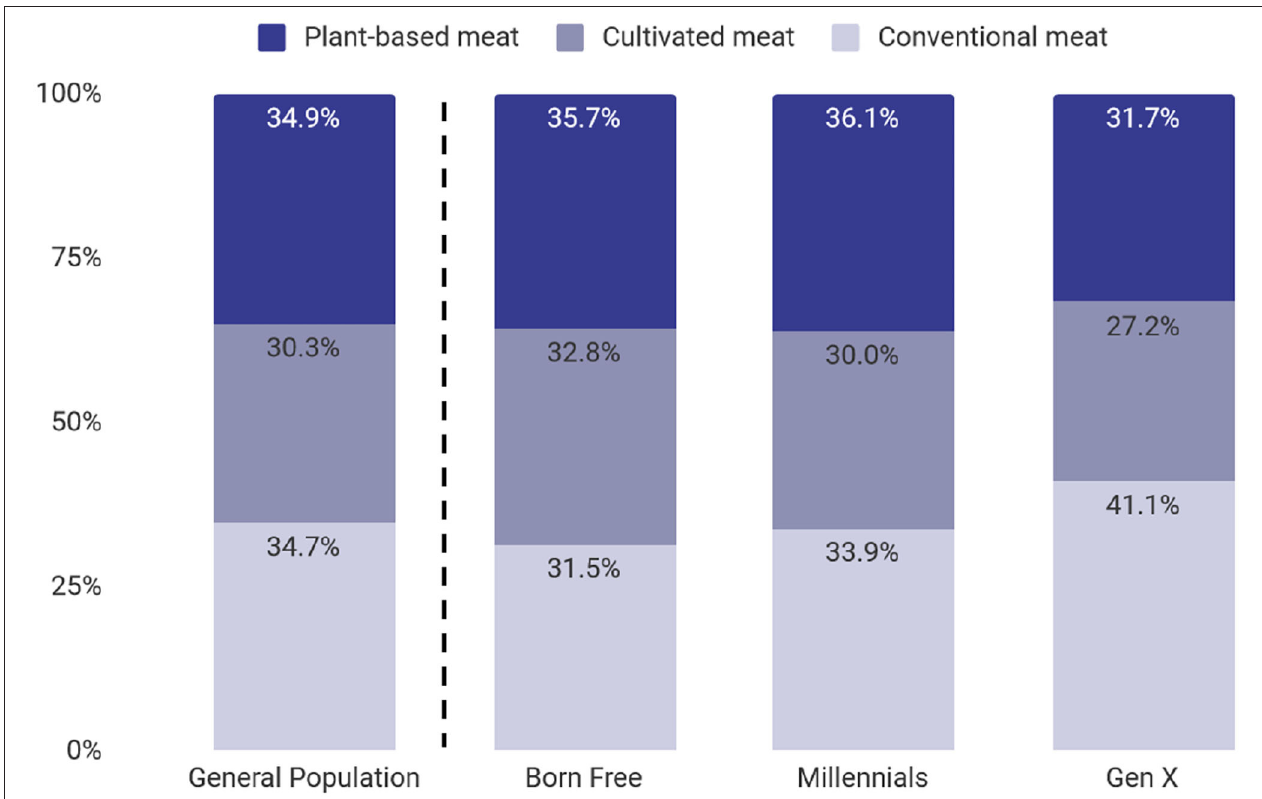
FIGURE 10 | Estimated future intake of meat categories in the general population and by generations. Our questionnaire also allowed for the option of not eating any of these types of meat. However, in the analysis, we excluded this option (which made up roughly 5–6% of the estimated future intake) and recalibrated the percentages such that the shares of the three meat categories add up to 100%. This allowed for a more straightforward comparison of the estimated future intake of plant-based, cultivated and conventional